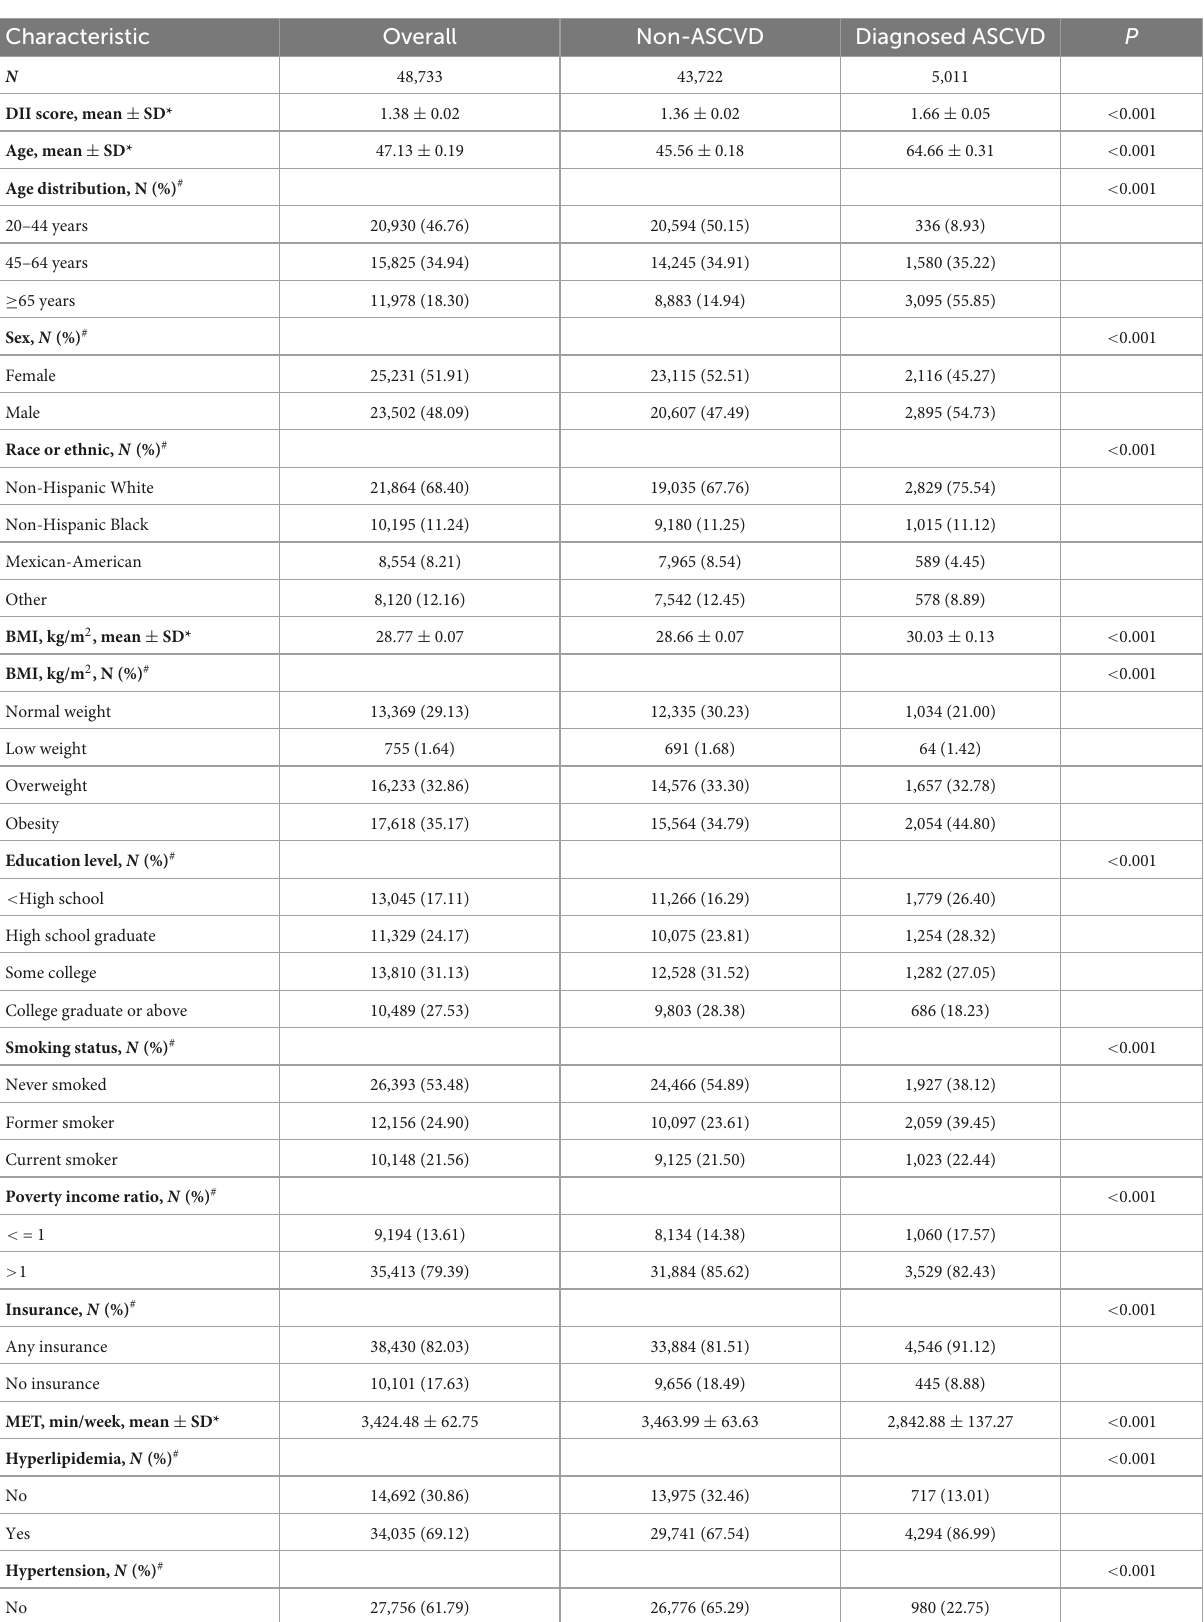
TABLE 1 Baseline characteristics of participants, from National Health and Nutrition Examination Survey (NHANES) 1999–2018. Characteristic Overall